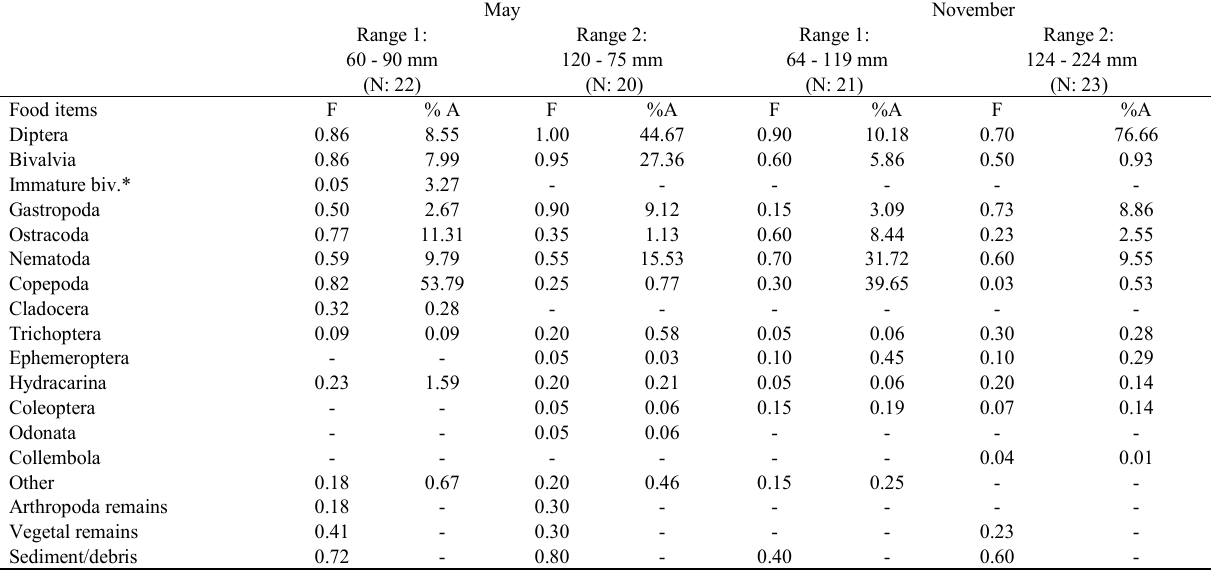
Table 3. Descriptive estimations of Iheringichthys labrosus diet: frequency of occurrence (F) and percent abundance (% A) of prey items. Estimations were made from captures of May and November to individuals for each size class (1 and 2), from Uruguay River (Uruguay). *Immature biv.: immature bivalvia; item separately from Bivalvia group because of it high abundance, small size and low frequency of